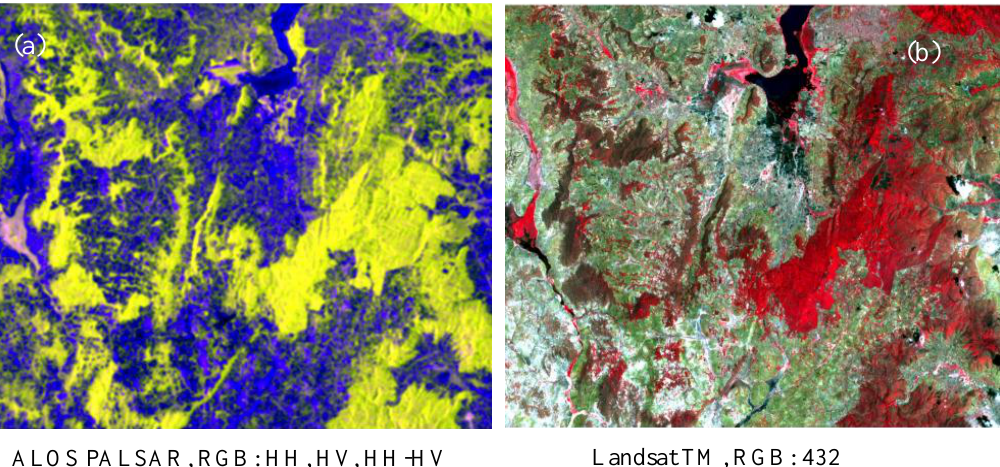
Figure 3 . Utilized images ( a ) ALOS PALSAR, RGB: HH, HV, HH-HV. ( b ) Landsat 5-TM, RGB: 432.